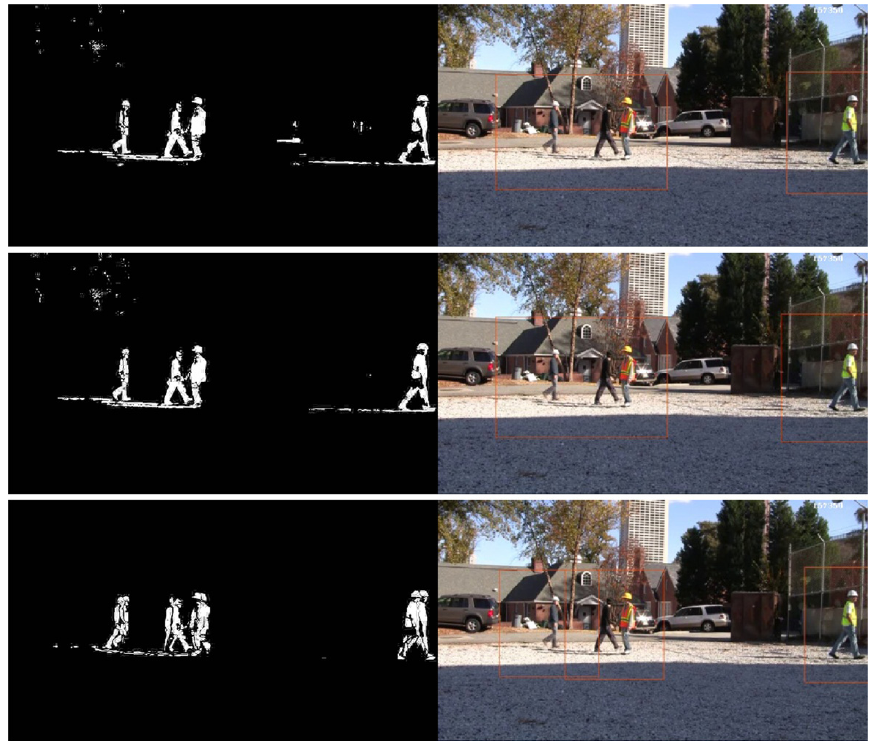
Figure 10. Background subtraction legend. Reproduced with permission from ref. [45]. Copyright 2012 Elsevier.